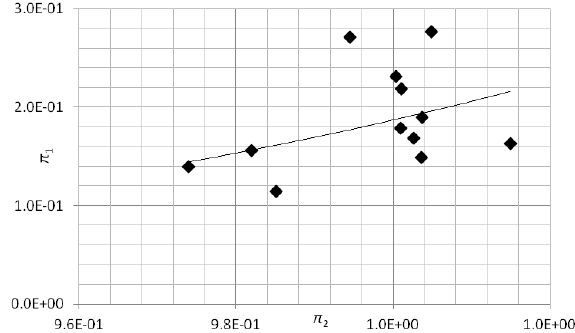
Fig. 3. Non-dimensional arguments and regression line for phos- phorus Figure 3. Non-dimensional arguments and regression line for phosphorus concentrations. 3